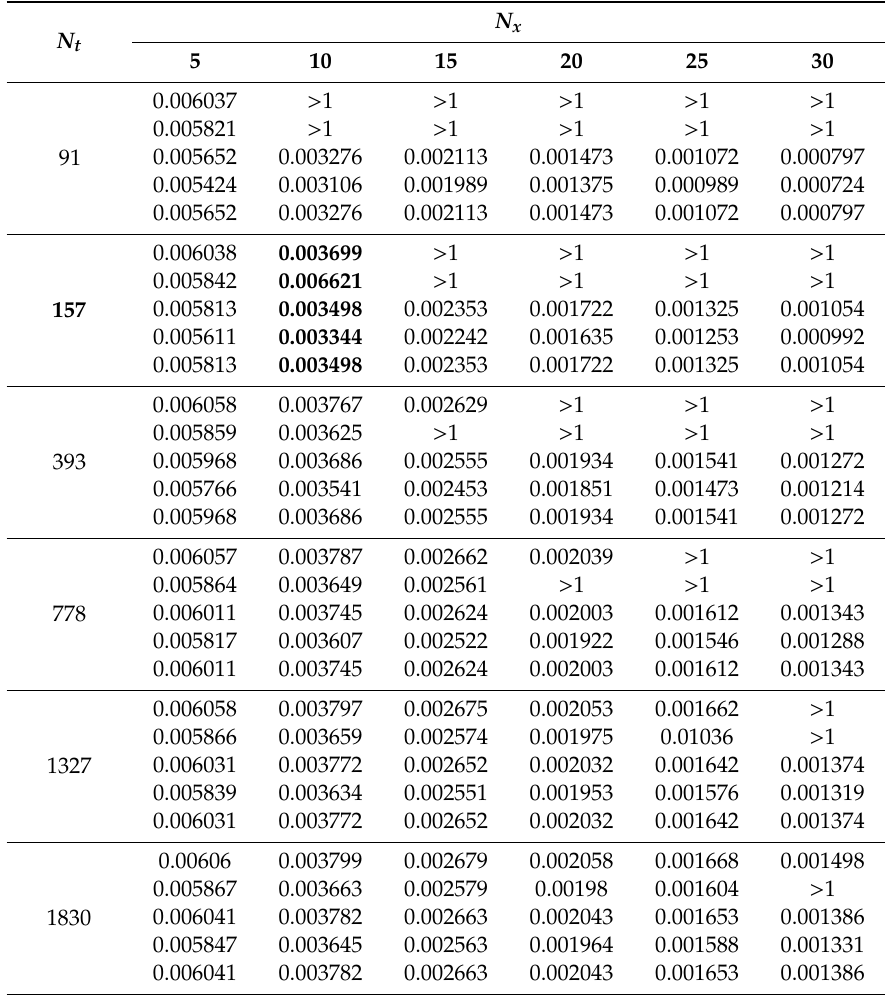
Table A3. Comparisons of average absolute values of relative errors (in comparison with the exact solution) for used di ff erence schemes and the generation